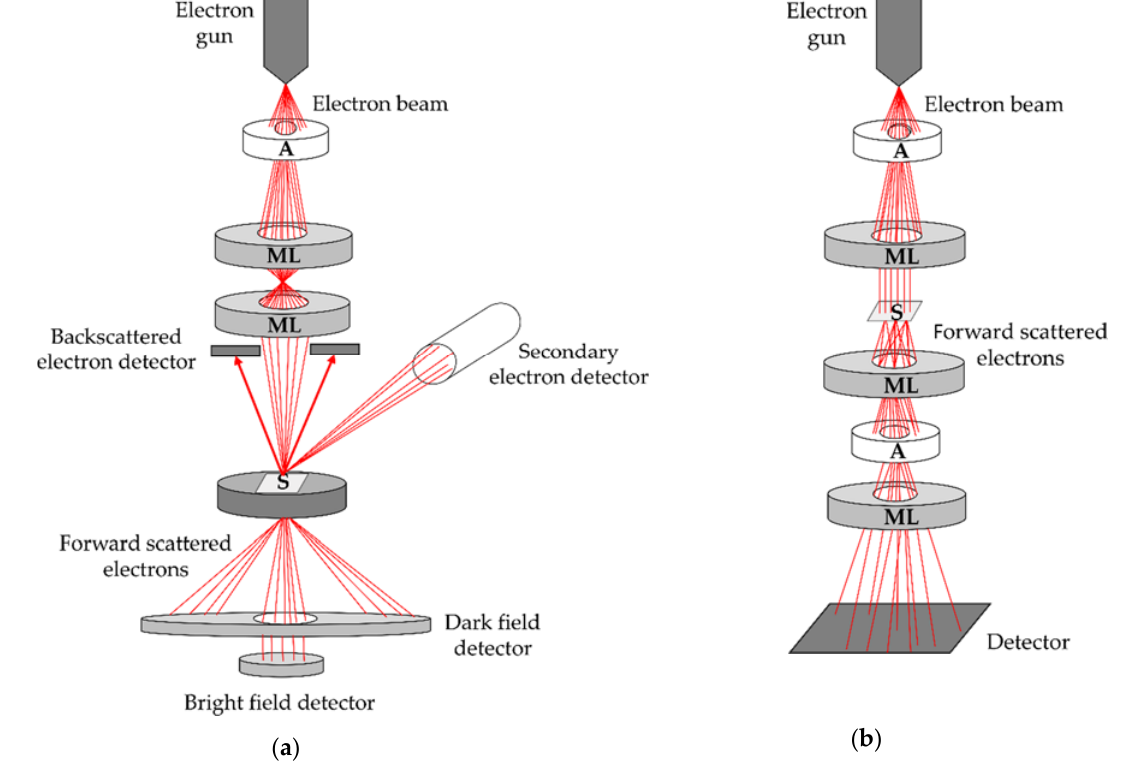
Figure 1. Electron microscopy. Schematic representation of scanning electron microscope (SEM and STEM—with additional detectors installed below the sample to detect the transmitted electrons; ( a ) and transmission electron microscope (TEM; ( b ). A: aperture, ML: magnetic lens, S: sample.